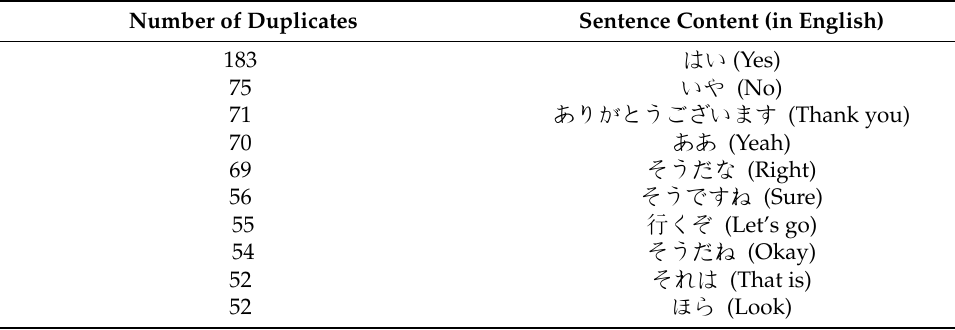
Table 8. Top 10 Japanese duplicate sentences in the corpus